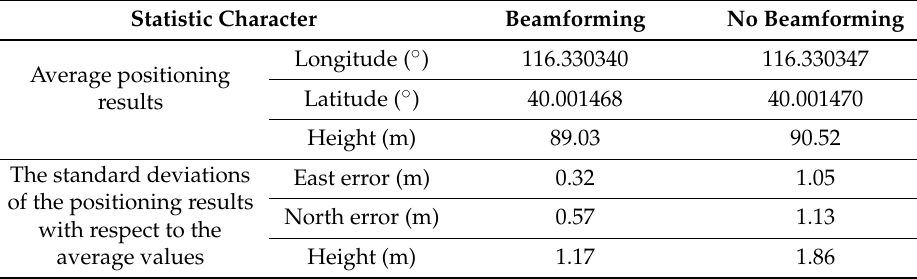
Table 6. The average values and standard deviations of the positioning